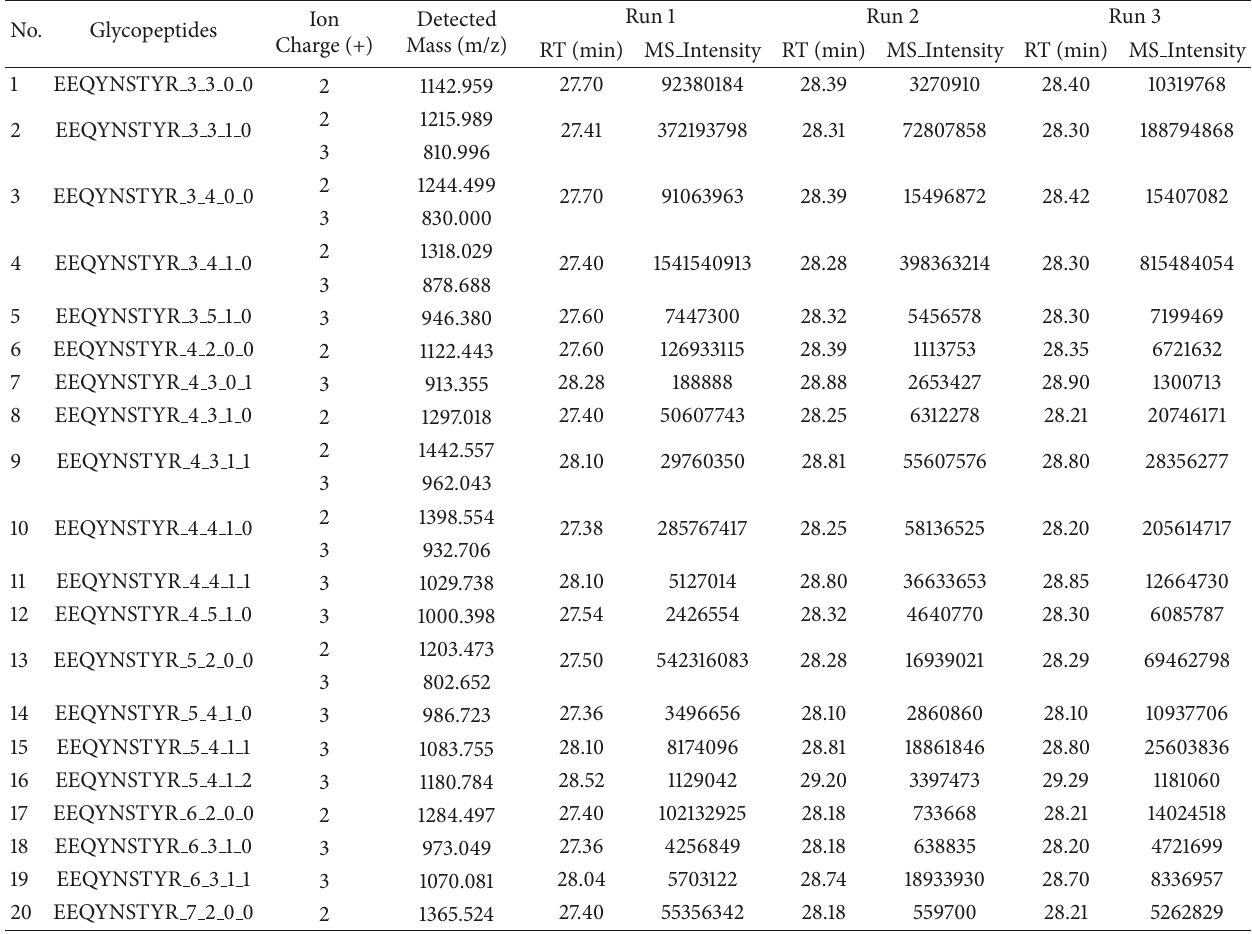
Table 1: List of tryptic glycopeptides from triplicate analysis of reference rAb a